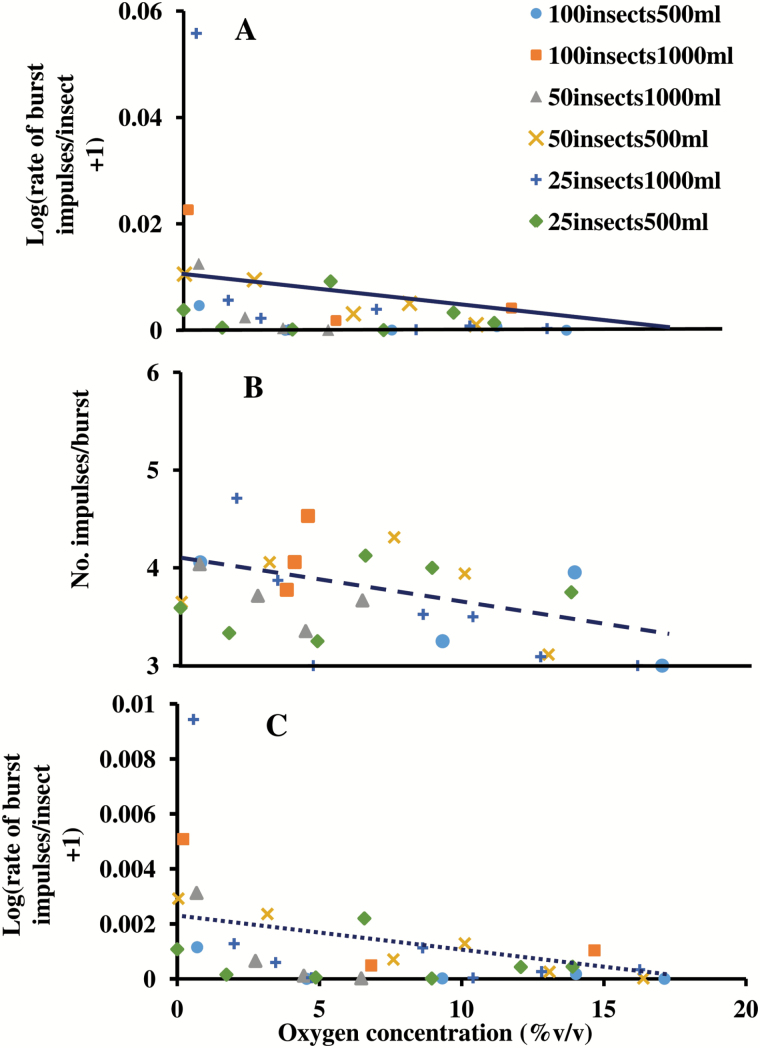
Acoustic activity at different O2 percentages in hermetic treatments measured as: (A) rate of burst impulses, Rbimp, normalized per No. insects per treatment, Nt, (Rbimp/Nt), (B) No. impulses per burst, and (C) rate of bursts, Rb, normalized per No. insects per treatment (Rb/Nt). Horizontal scale is % O2 and treatment mean values at each O2 value are designated as: 25 insects/500 ml, diamond; 25 insects/1,000 ml, plus; 50 insects/500 ml, X; 50 insects/1000 ml, triangle; 100 insects/500 ml, square; and 100 insects/1,000 ml, circle. Vertical scale units are (A) 0.01, (B) 1, and (C) 0.01. Vertical scale values are: (A) Log10 (Rbimp/Nt+1); (B) No. impulses per burst; and (C) Log10(Rb/Nt+1). Regressions are shown as (A) solid line, (B) dashed line, and (C) dotted line.